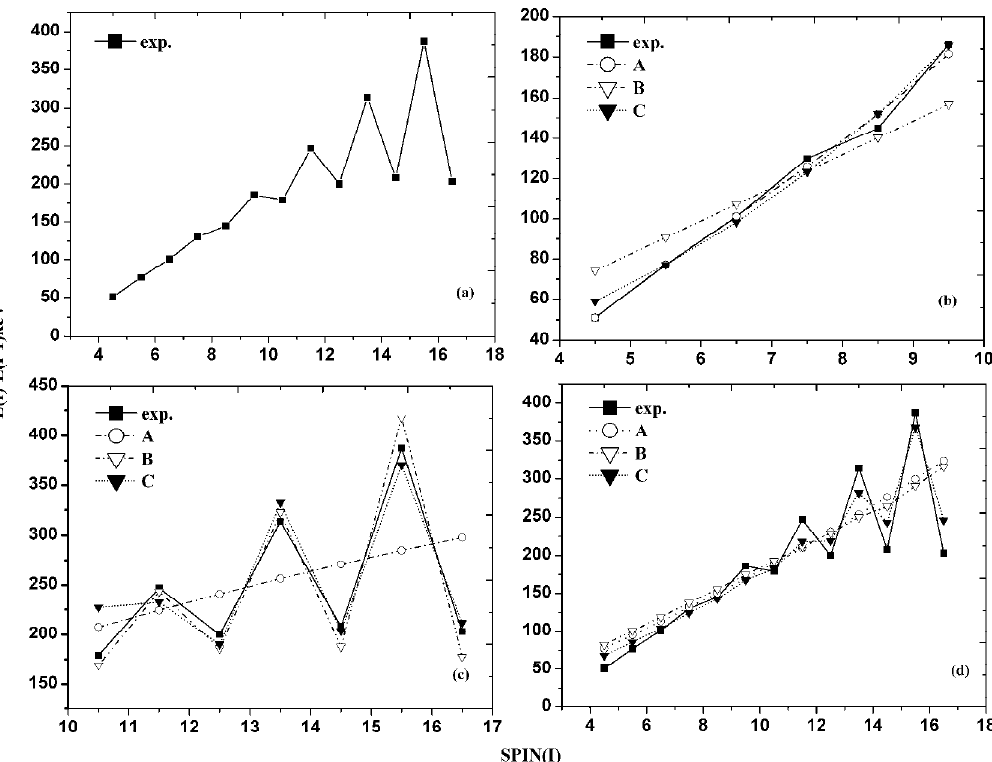
Figure 1. The comparison of PRM calculations with experimental results: (A) angular momentum dependence of moment of inertia as a free parameter without RCT, (B) without considering angular momentum dependence of moment of inertia but with inclusion of RCT in total Hamiltonion, and (C) angular momentum dependence of moment of inertia as a free parameter along with RCT in total